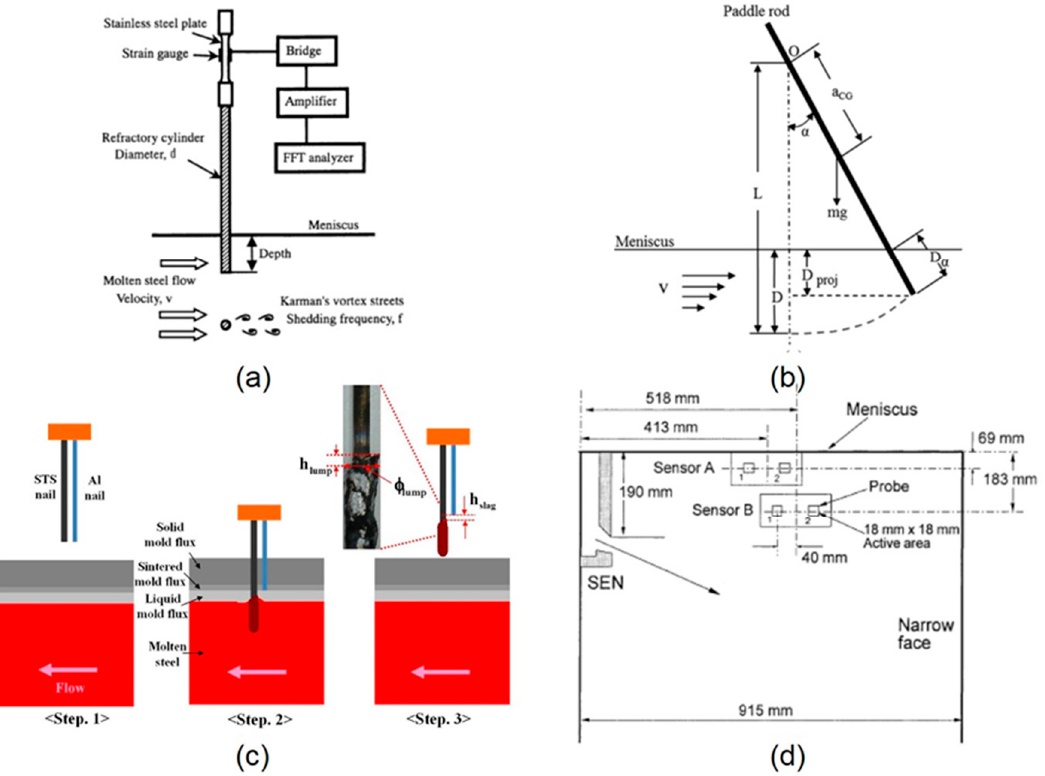
Figure 2. Plant flow–velocity measurements: ( a ) strain gauge test [52], ( b ) paddle rod test [55], ( c ) nail dipping method [64], and ( d ) electromagnetic mold flow control (MFC) test [66].